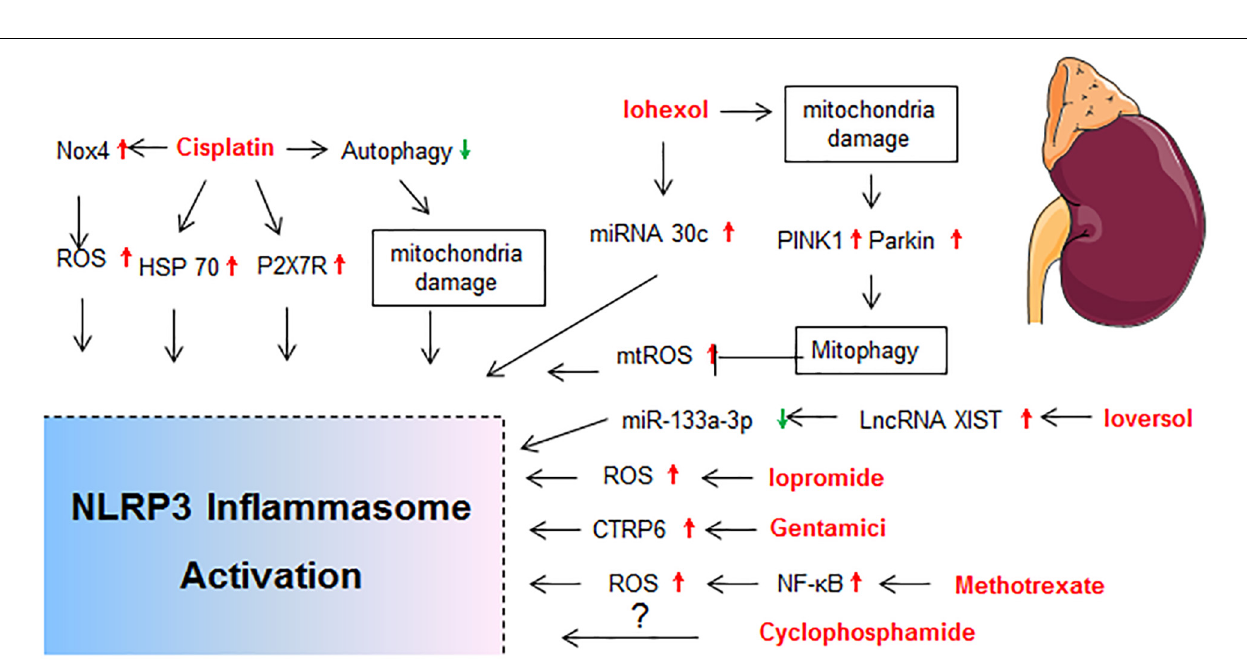
Frontiers in Cell and Developmental Biology | www.frontiersin.org